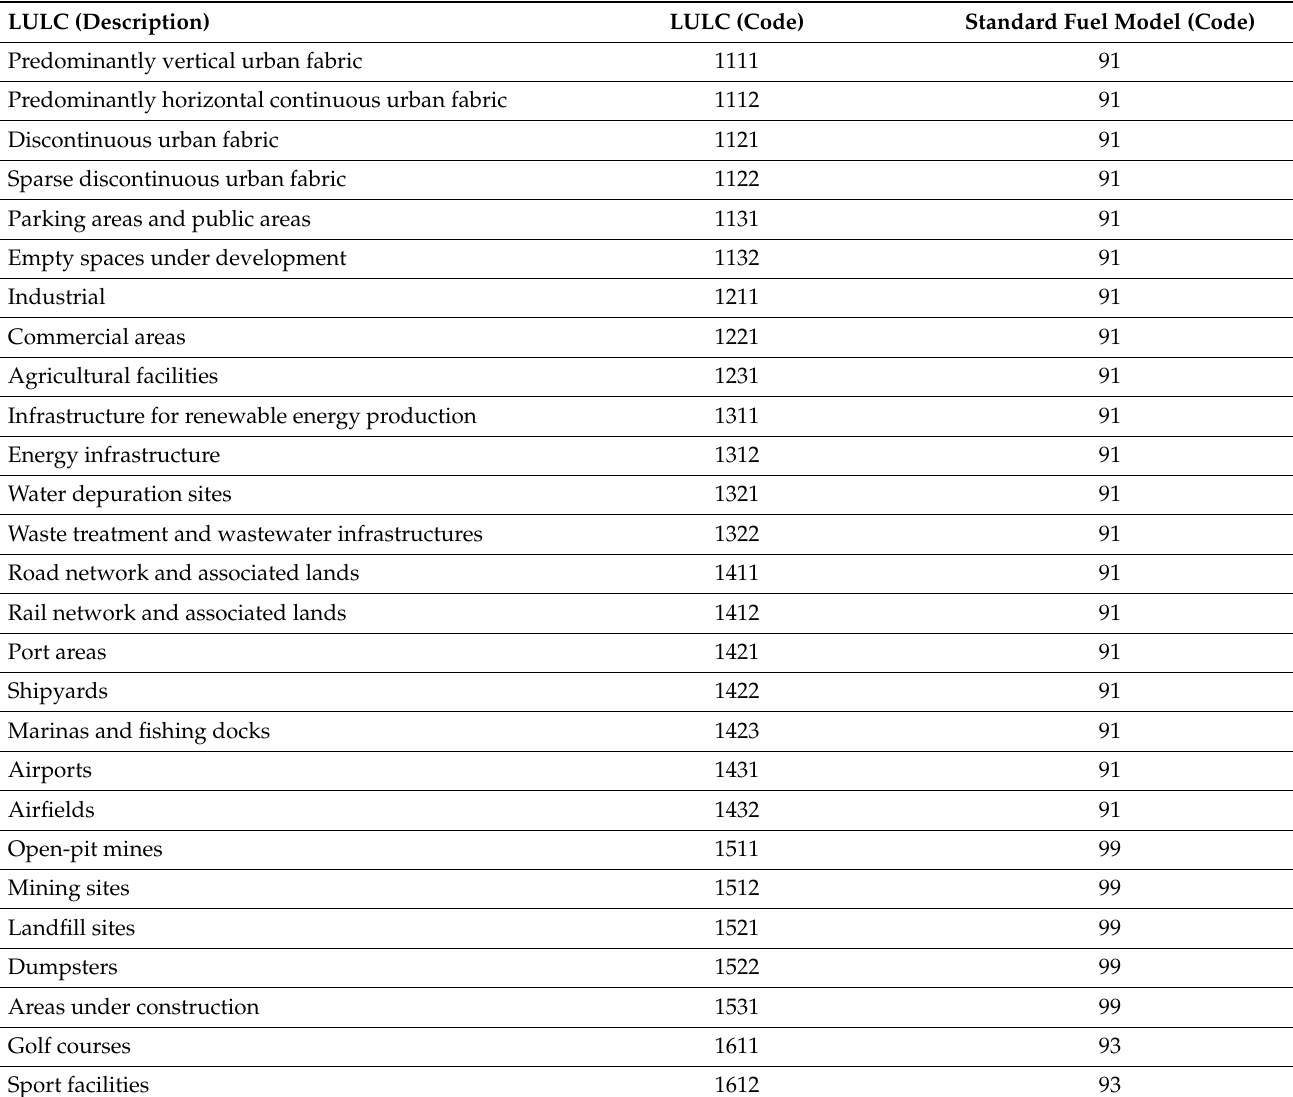
Table A2. Standard fuel model assignation to 2018 land-use land cover classes [32,50]. We used these fuel model